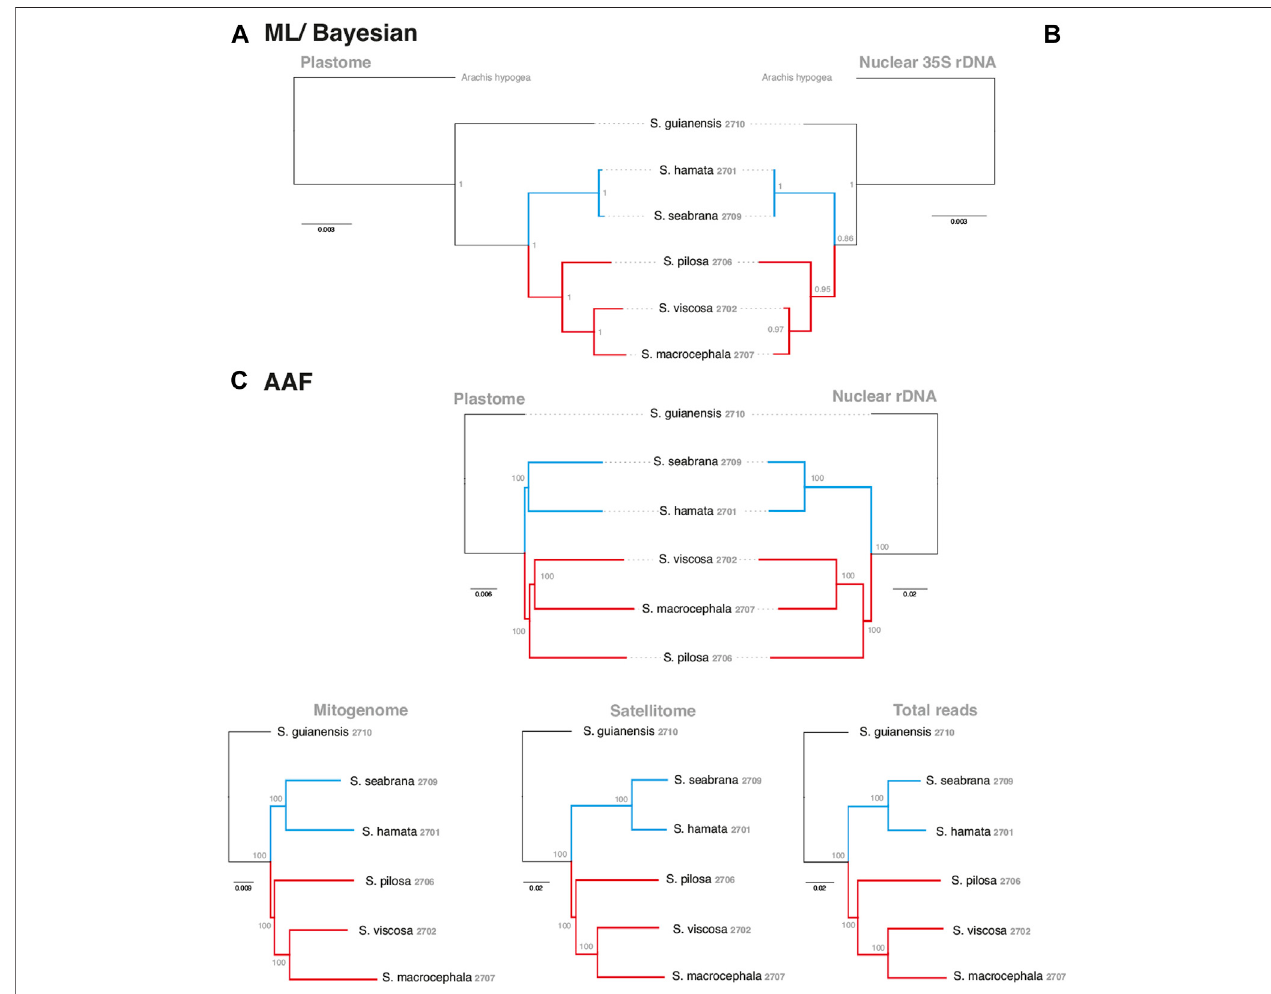
FIGURE 4| Alignment-based (A – B) and AAF (C) phylogenies ofthe Stylosanthes diploid species based on different datasets. Each dataset used in the respective inferenceis indicated on the top ofeach tree.Blue branchesindicate Agenome-speci fi cand red branchesgroup other genome types. Numbers indicate speci fi c codes for each sample (see Table 1